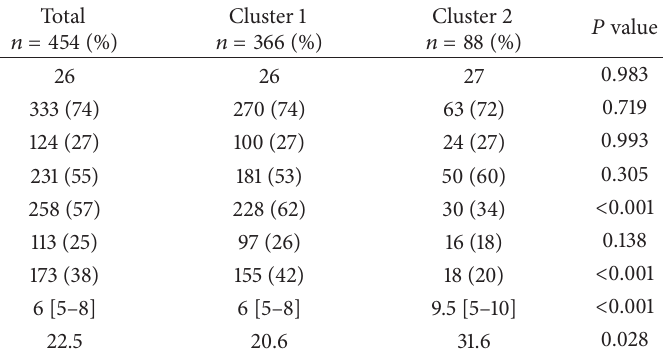
Table 1: Cluster analysis of symptoms of 454 brucellosis cases in